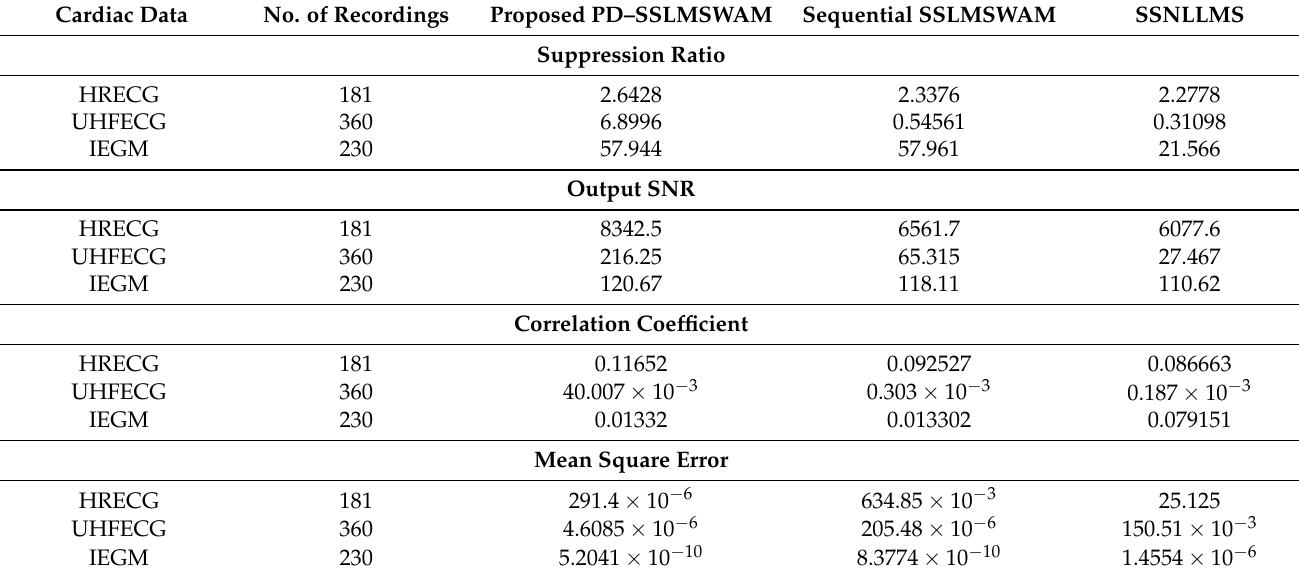
Table 4. Statistical analysis of the proposed PD–SSLMSWAM, sequentially operated SSLMSWAM, and SSNLMS algorithm for real cardiac